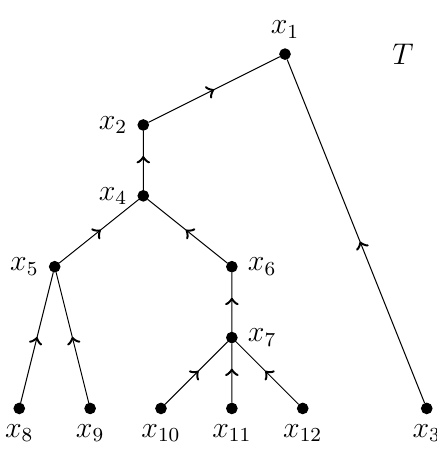
Figure 9: Let x be a root of T , u ( x , x , x , x , x , x ) and v 8 5 4 6 7 12 join x and x with the root r = x 8 12